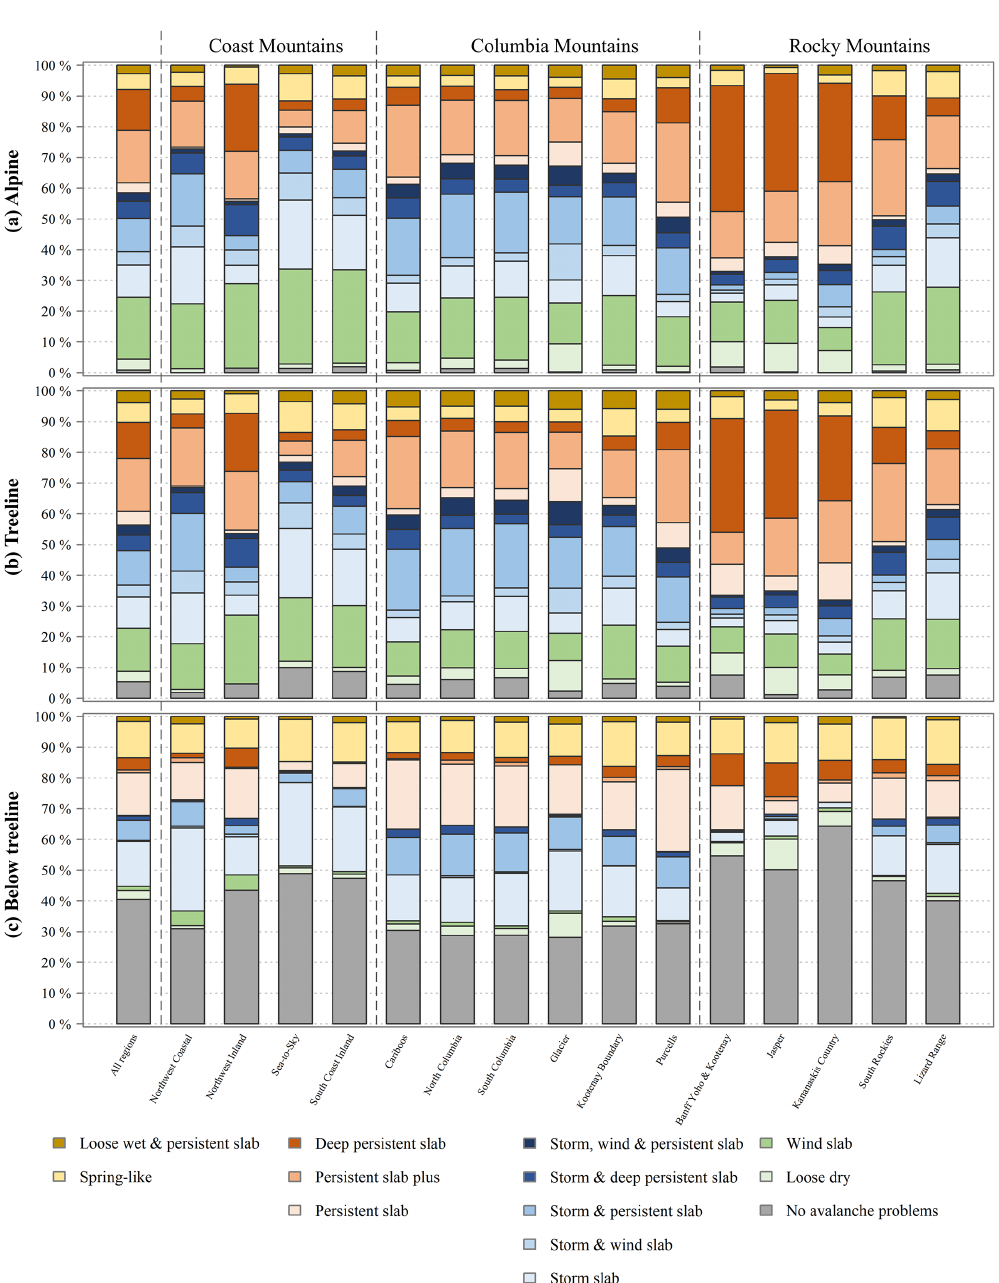
Figure 5. Average hazard situation prevalence for each forecast region in the alpine, treeline and below treeline elevation bands from 2011/2012 to